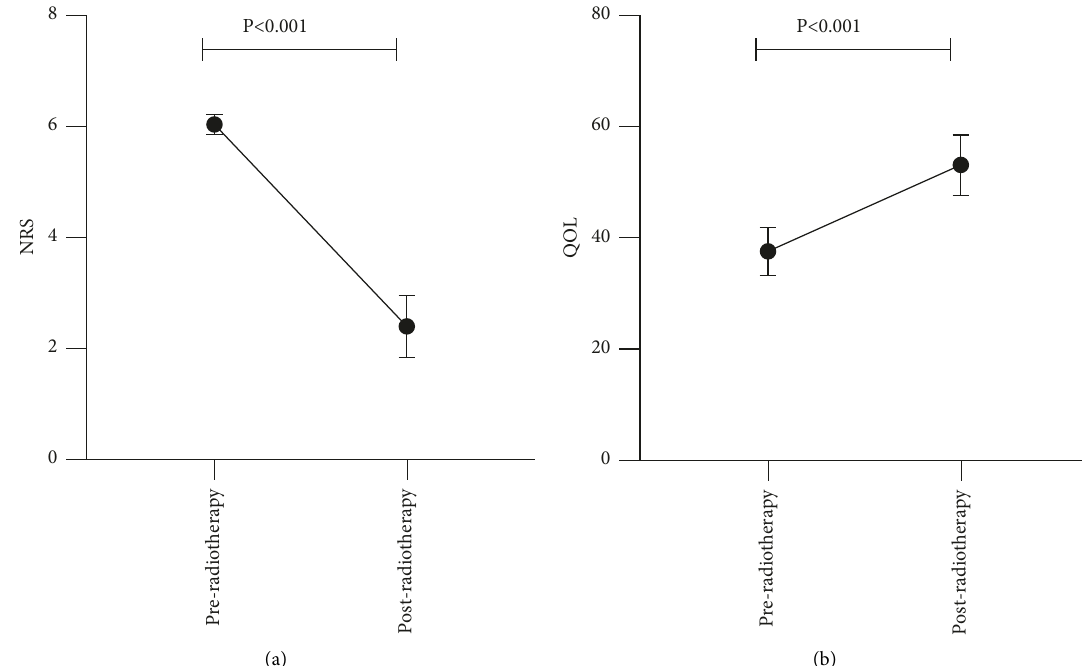
Figure 1: Comparison of pain and quality of life preradiotherapy and postradiotherapy. (a) Analysis of NRS preradiotherapy and postradiotherapy. (b) Analysis of QOL preradiotherapy and